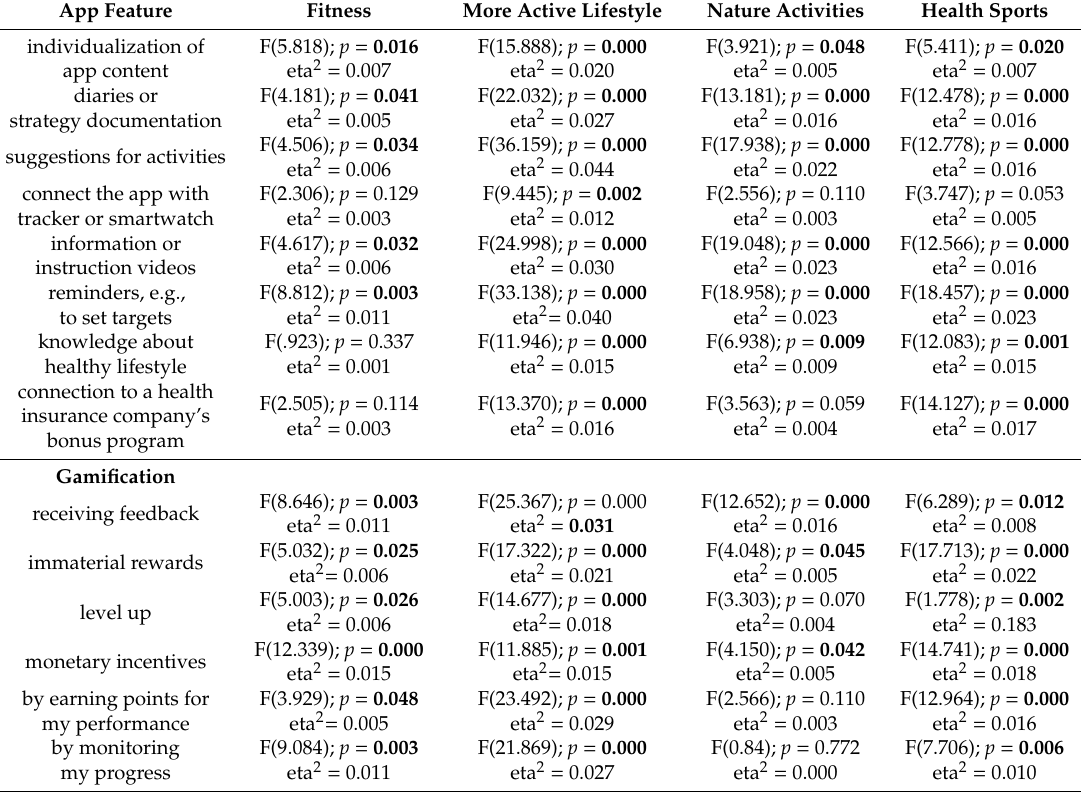
Table 2. Targets for an increase in physical activity and interest in app features and